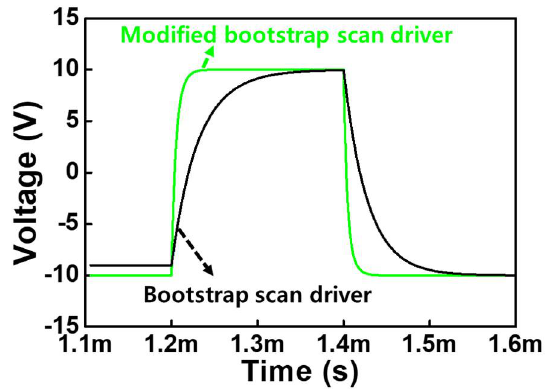
Figure 9. More detailed comparison between outputs for both the bootstrap circuit and modified bootstrap circuit.